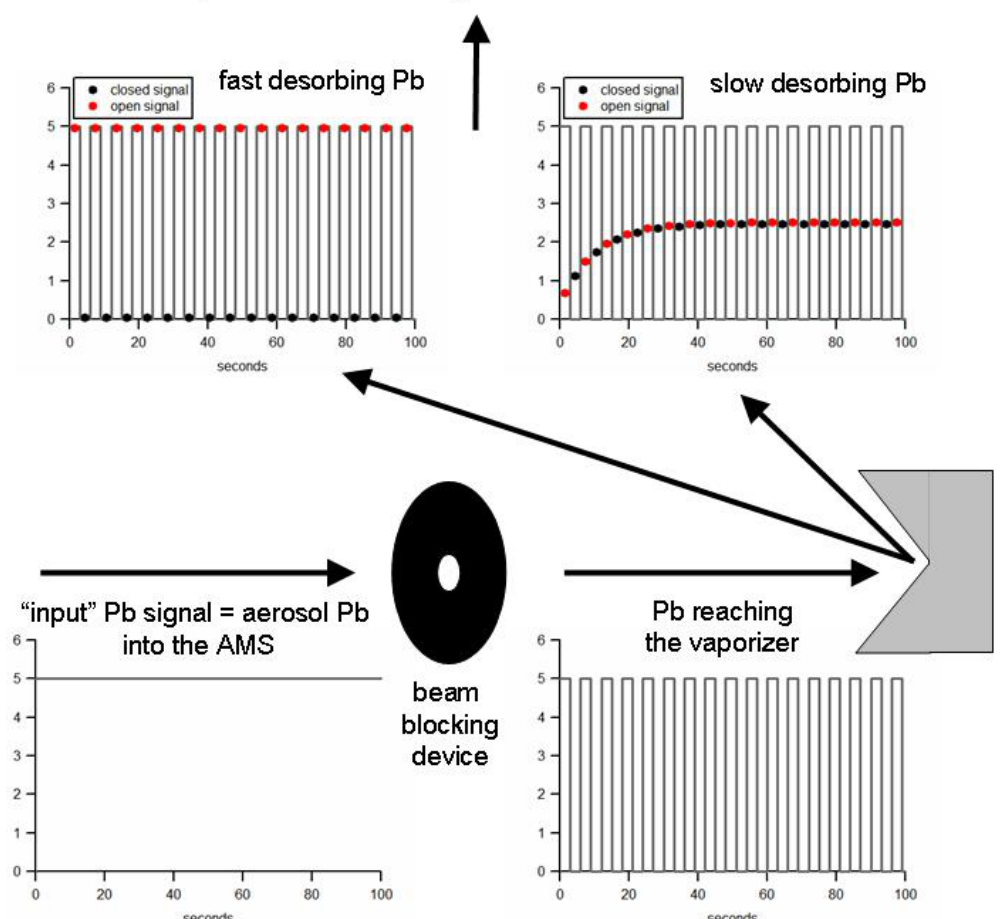
Fig. 7. Diagram of the adsorption/desorption model used to calculate the “input” total Pb signal. Given a constant input of 5µg/m 3 (lower left), the beam blocking device modulates the incoming signal (lower right). For fast desorbing Pb components, this modulation fully separates the “open” signal from a “closed” background (upper left). For the slow desorbing Pb components, the detection of the sampled Pb is nearly independent of the modulation (upper right) and the total measured signal is the sum of the “open” and “closed” fractions.